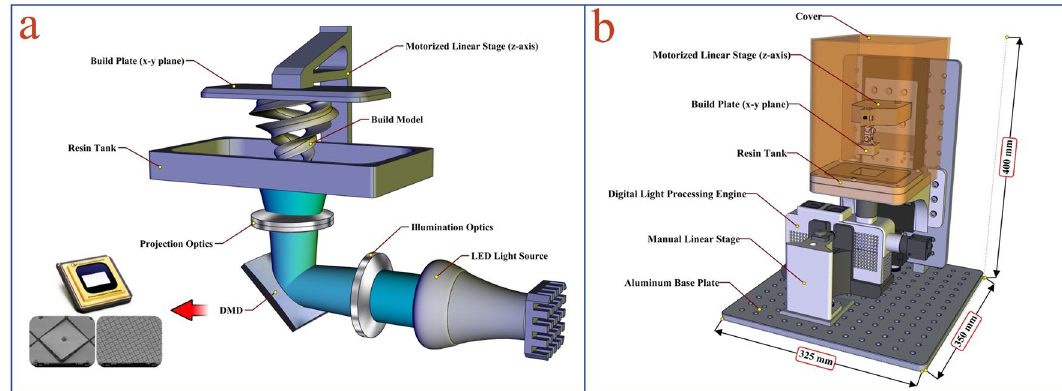
Figure 2. ( a ) The schematic illustration of the bottom-up configuration and ( b ) The 3D CAD model of the designed compact PµSL 3D printer. [This figure was created by SOLIDWORKS 2016 (www.solid works